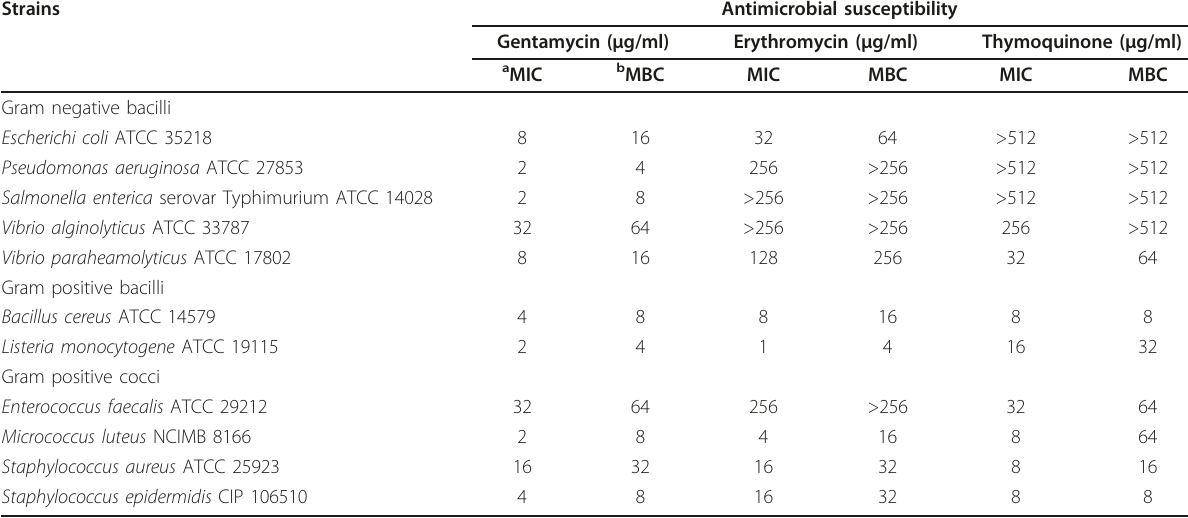
Table 1 Antibacterial activity of thymoquinone against Human pathogenics strains Strains